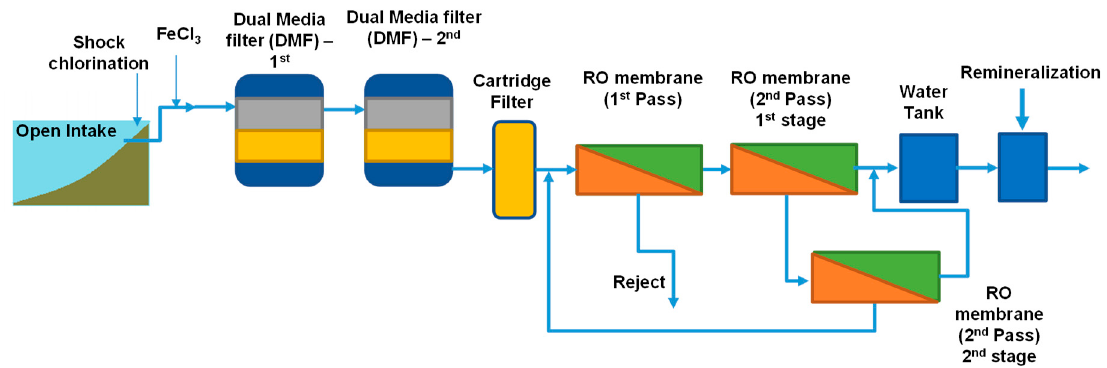
Figure 1. Schematic of the treatment processes of the seawater reverse osmosis (SWRO) desalination plant (plant A).